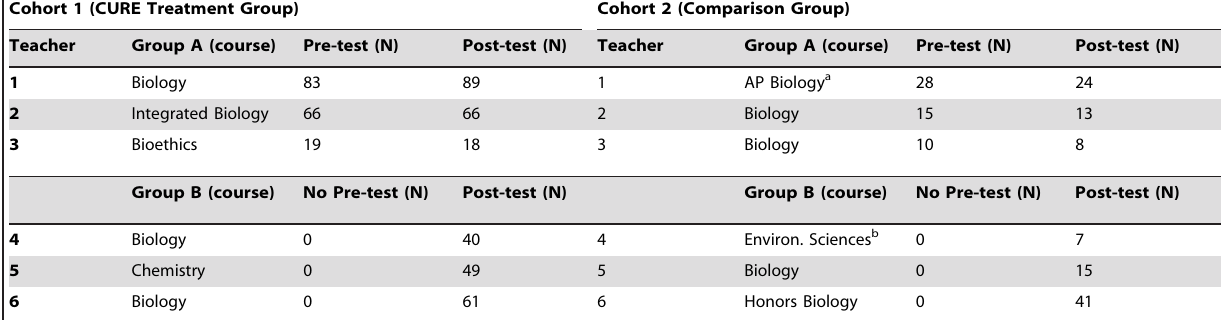
Table 2. Participants in the CURE Research